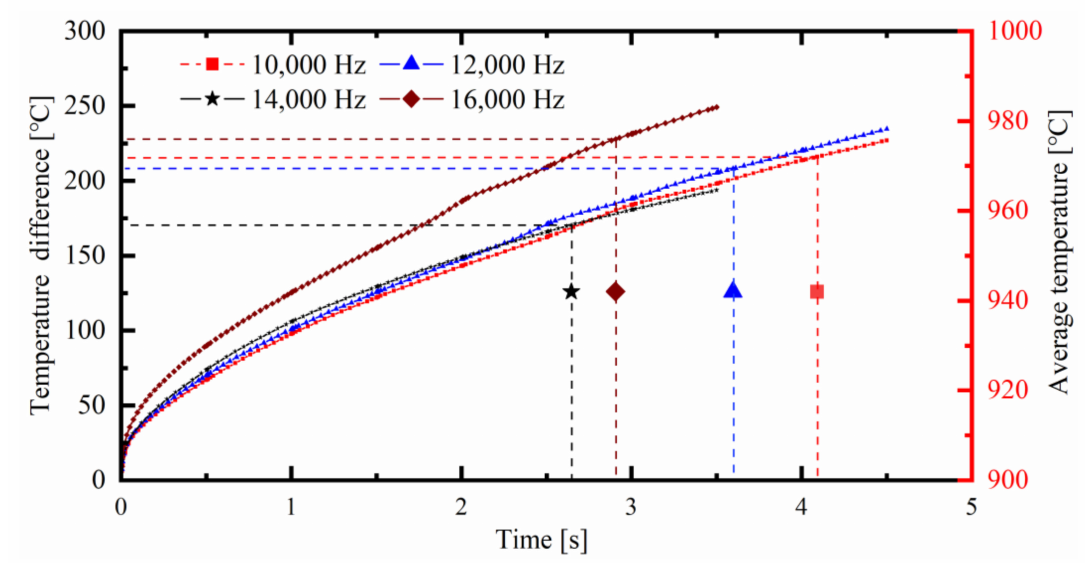
Figure 17. The temperature difference and average temperature of 942 ± 0.1 ◦ C with different current